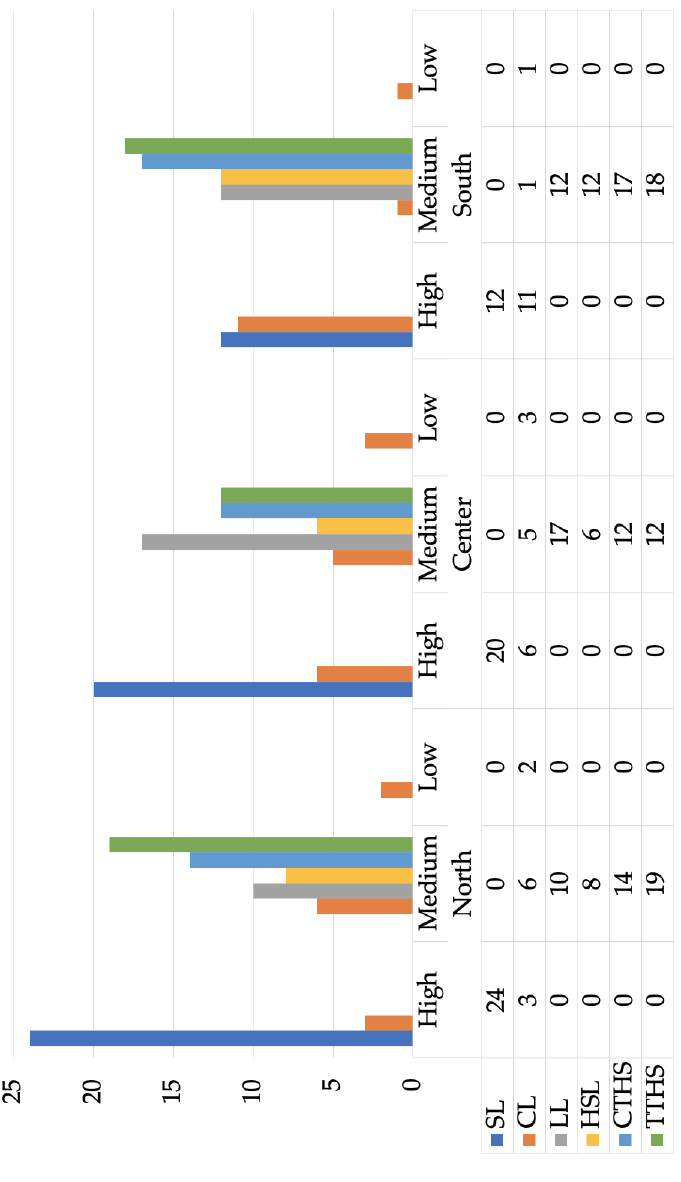
Figure 3: Performance of School sorted for typology and geographical areas